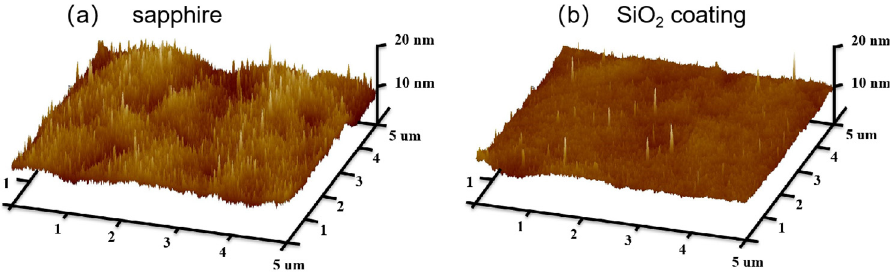
Figure 6. Surface morphology of ( a ) sapphire backside and ( b ) SiO 2 anti-reflection coating.